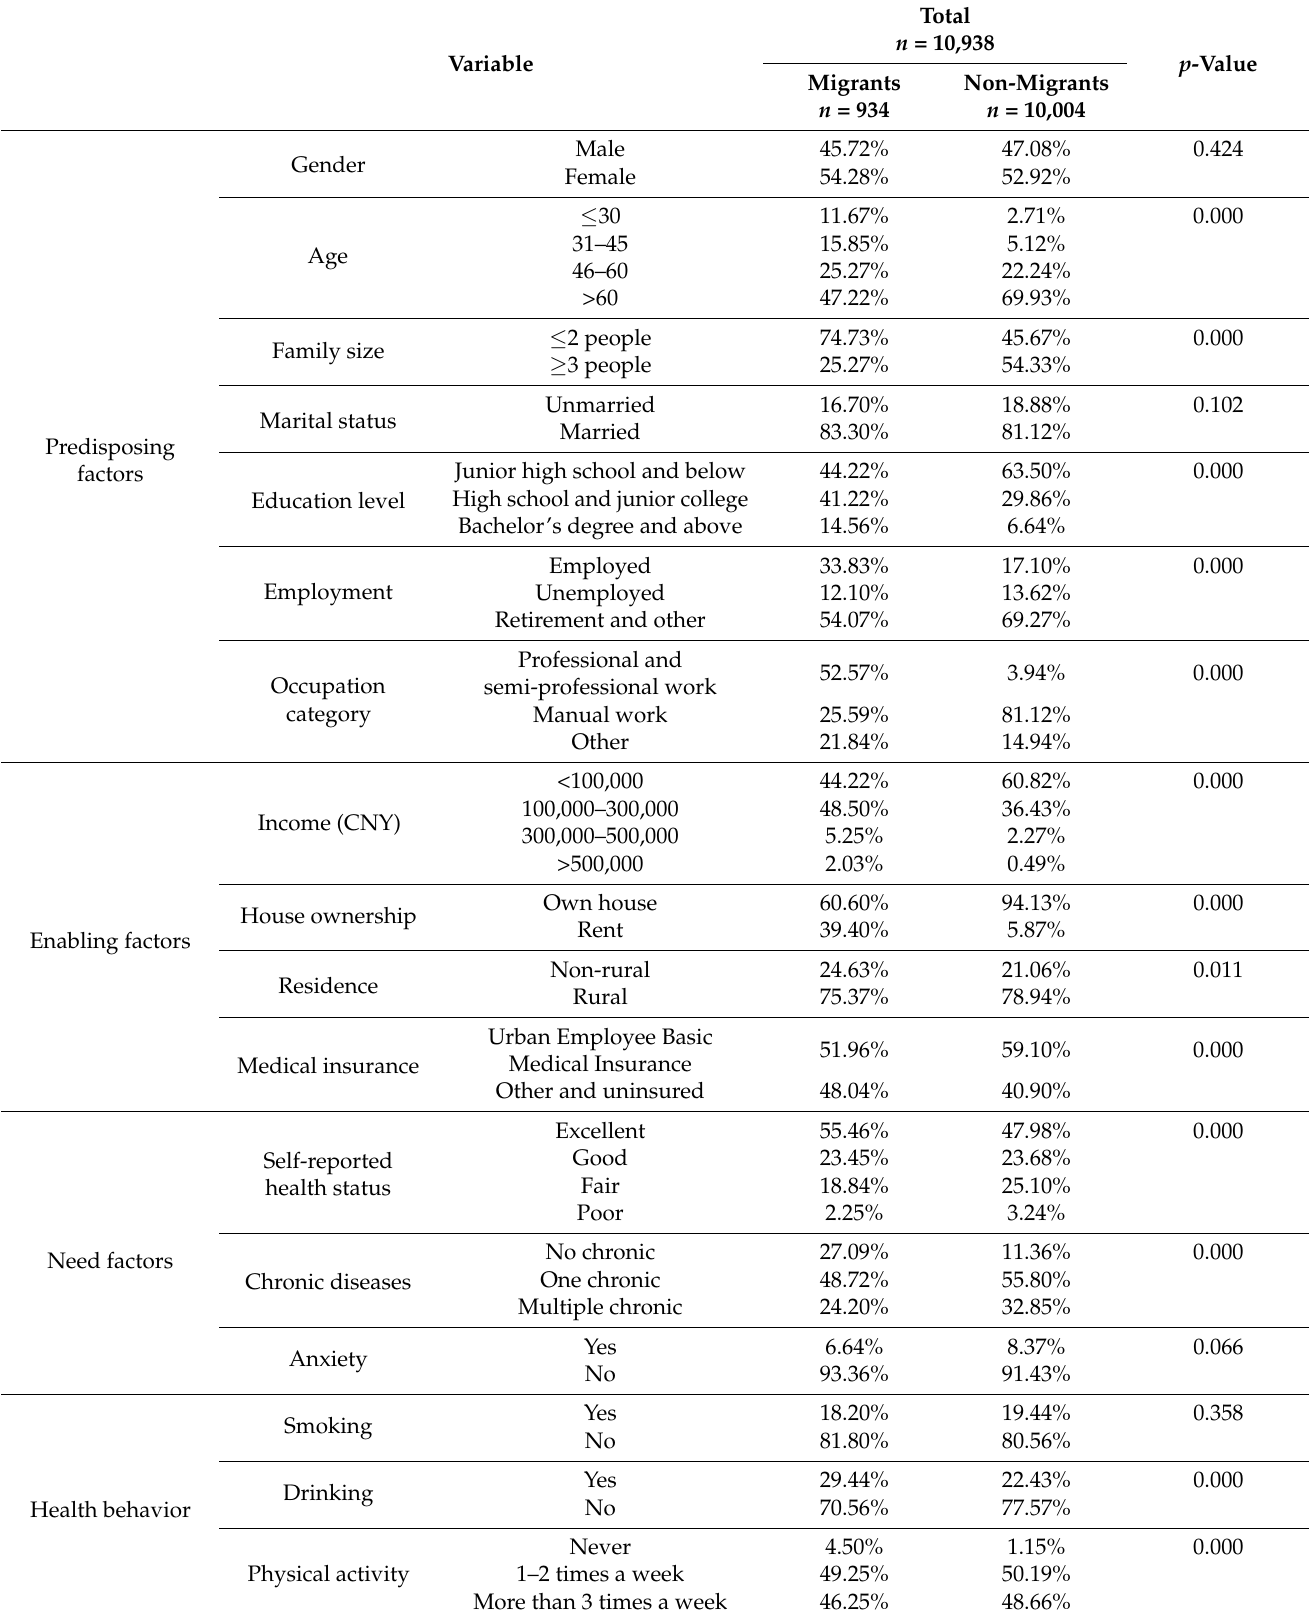
Table 1. Characteristics of unwell migrants and non-migrant participants in